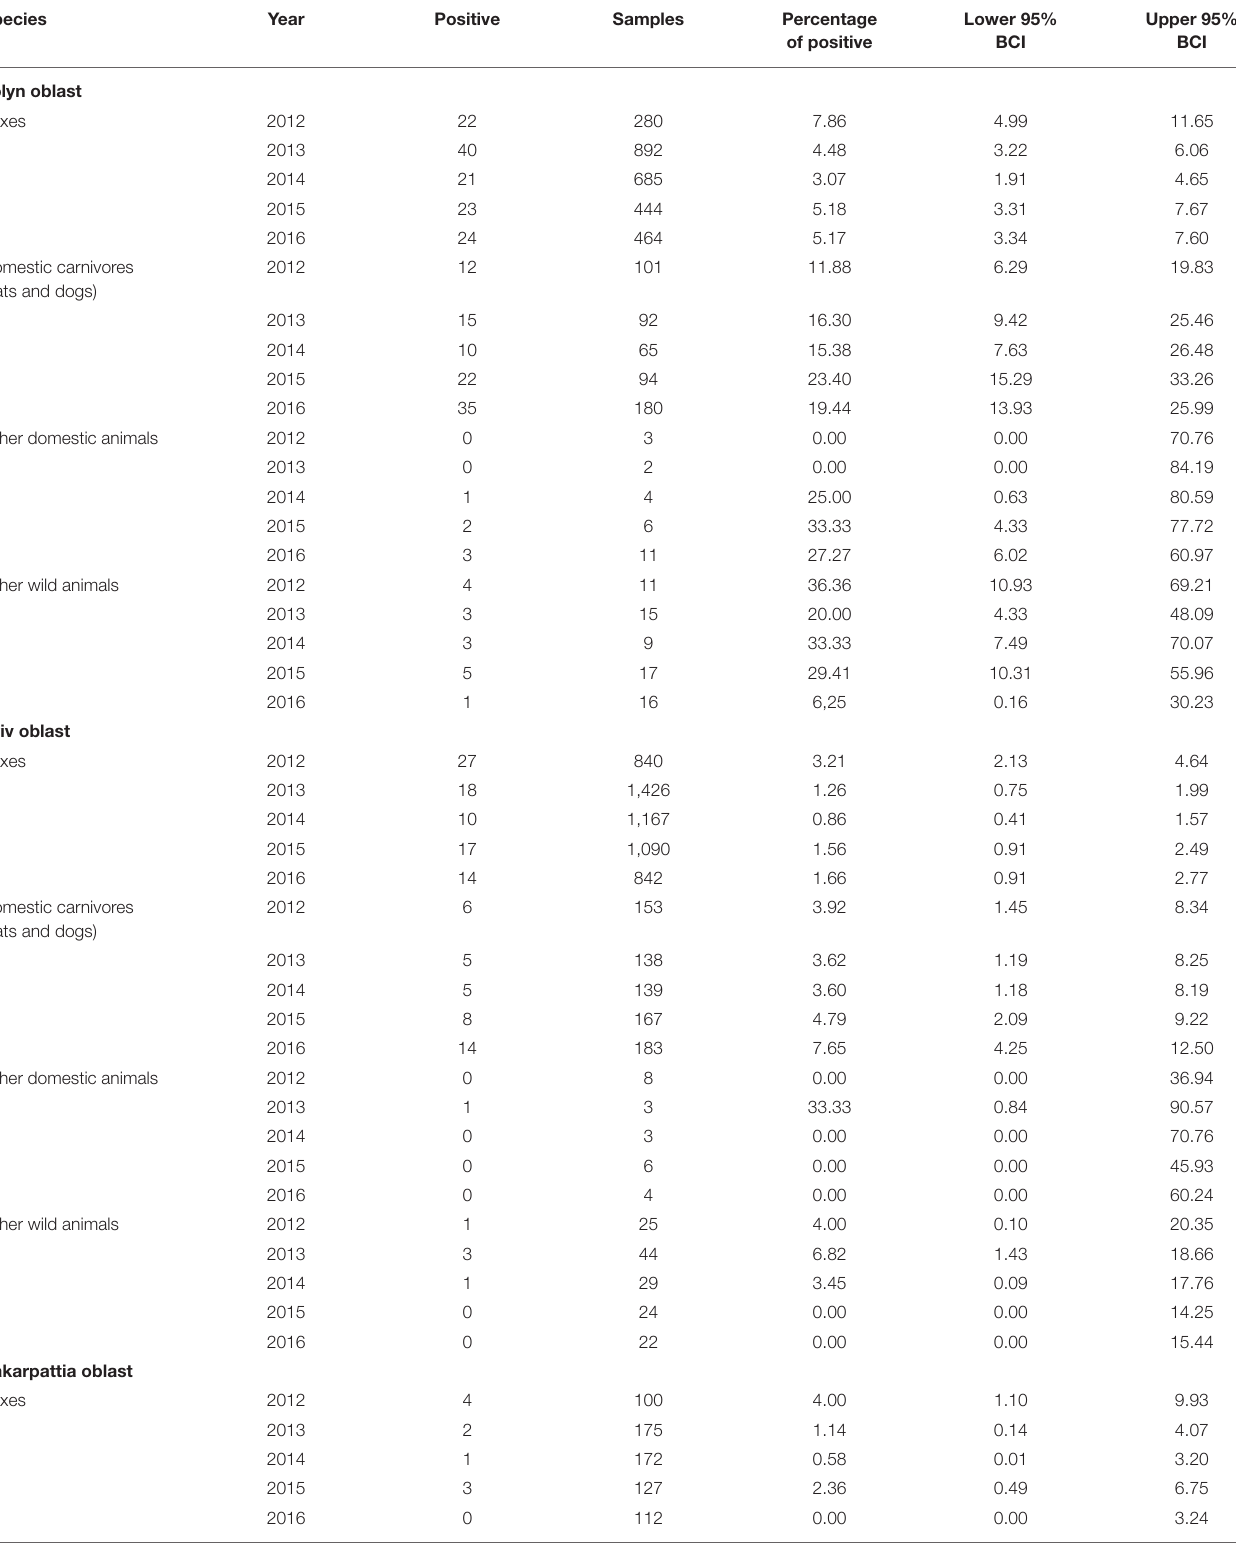
TABLE 3 | Rabies cases by year (2012–2016) for each oblast with 95% exact binomial confidence interval.